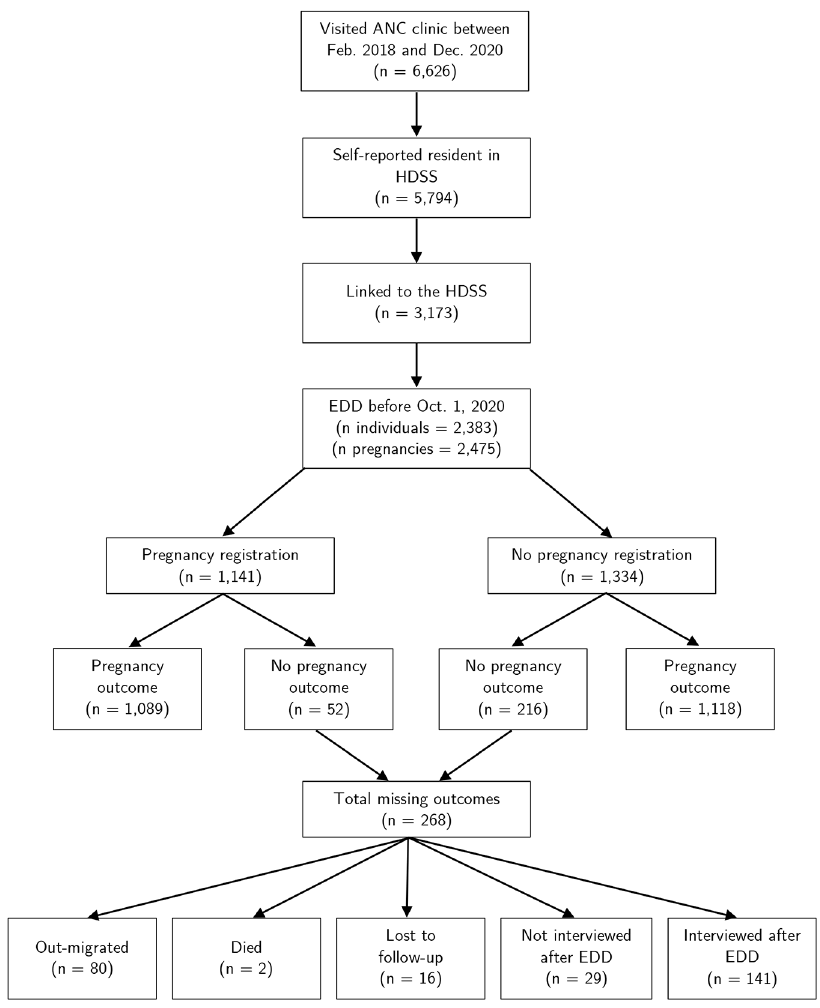
Figure 1: Flowchart of the sample included in the